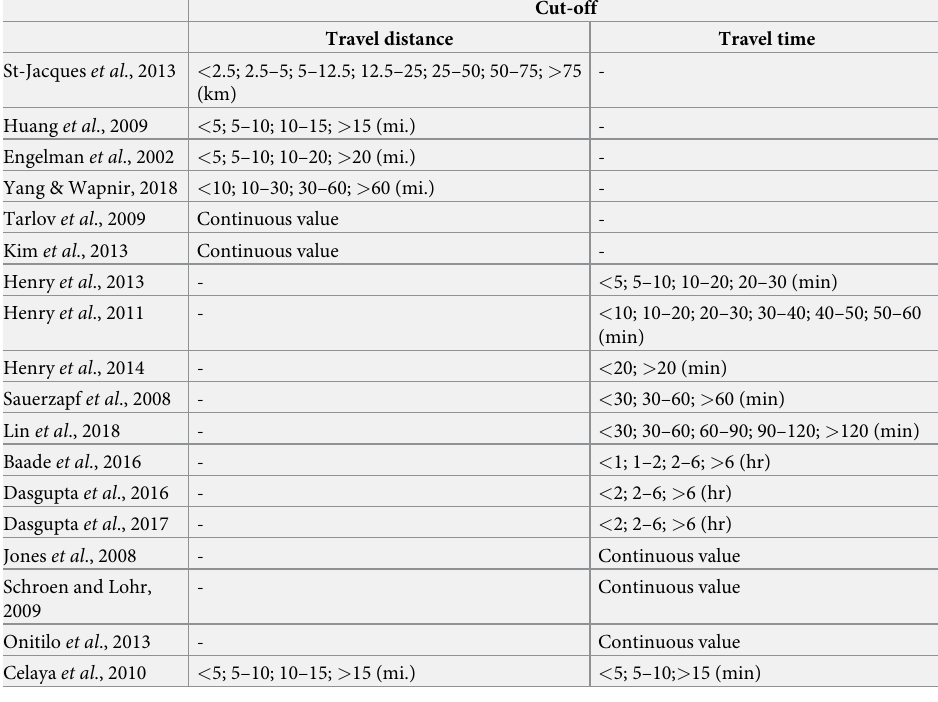
Table 2. Cut-off of travel distance and travel time of included articles.